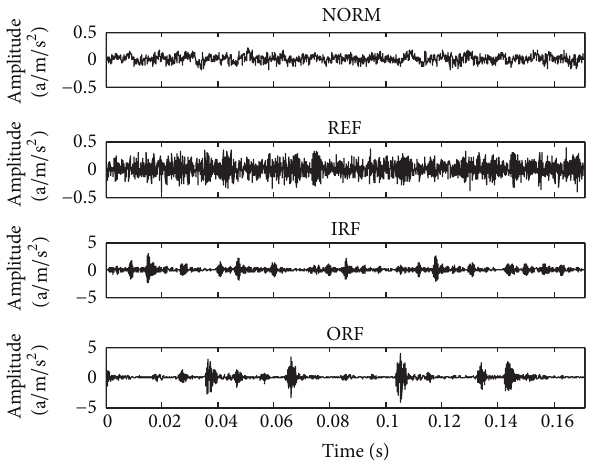
Figure 6: The MPE of normal and faulty bearing vibration signals. The results are the average of ten